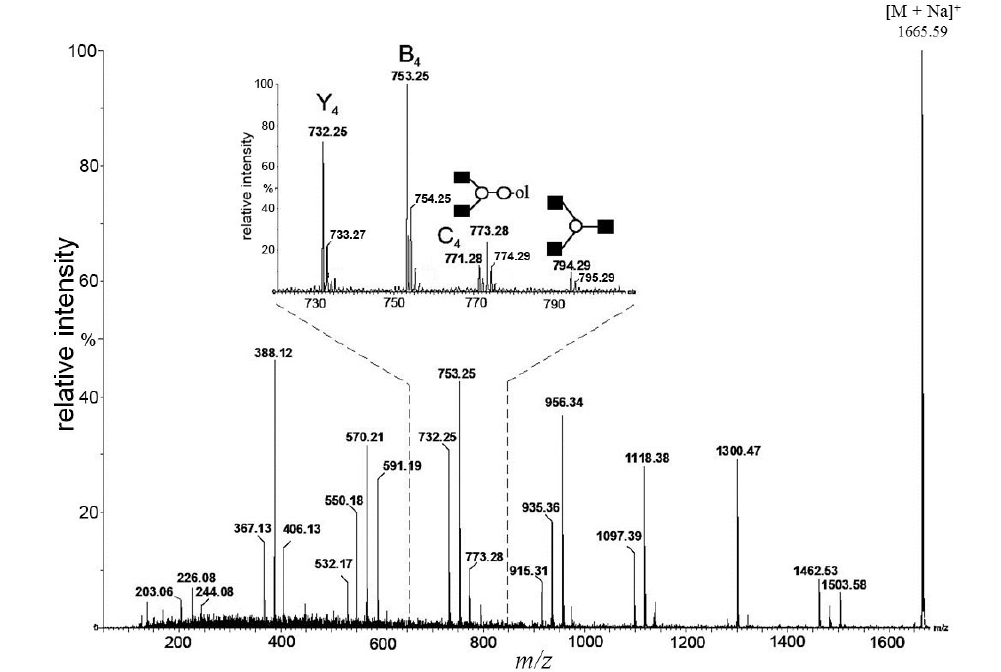
Figure 4. Fragmentation spectrum of the parent ion at m / z = 1665.59. The analysis of fragment ions revealed the presence of isobaric nonasaccharide